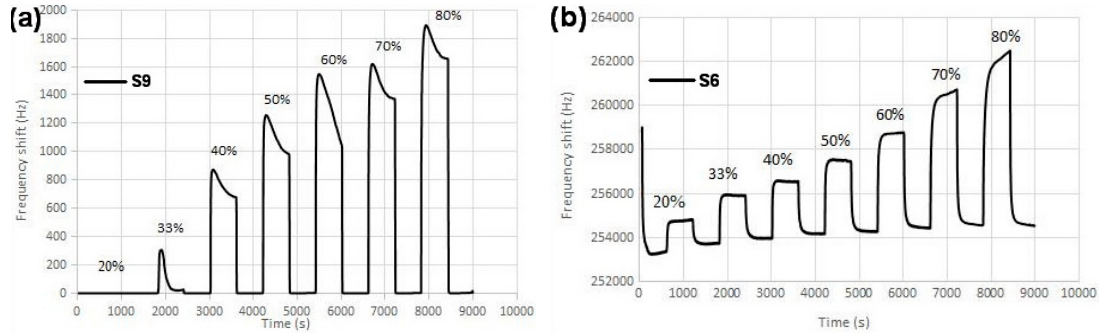
Figure 5. ( a ) An uncoated SAW sensor (S9) and ( b ) an AgNW-coated SAW sensor (S6) response against humidity in seven different humidity percentage in the range of 20%–80% RH. The baseline corresponds to 0% RH. Frequency vs. RH% graph, which indicates sensor sensitivity, for Sensor S6 and the uncoated one, is shown in Figure 6. It shows that the sensitivity of the SAW sensor with a AgNW-coated surface is higher than the uncoated SAW sensor. For Sensor S6, the frequency shift in 80% RH is about 6.5 kHz, which is three times greater than the uncoated sensor at 80% RH.